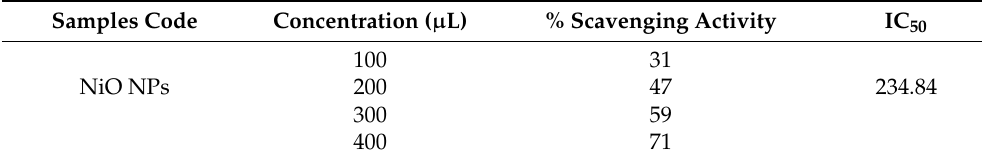
Figure 9. Graphical representation of antioxidant activity of green synthesized NiO NPs. Table 3. Percentage scavenging activity (%) of biogenic NiO